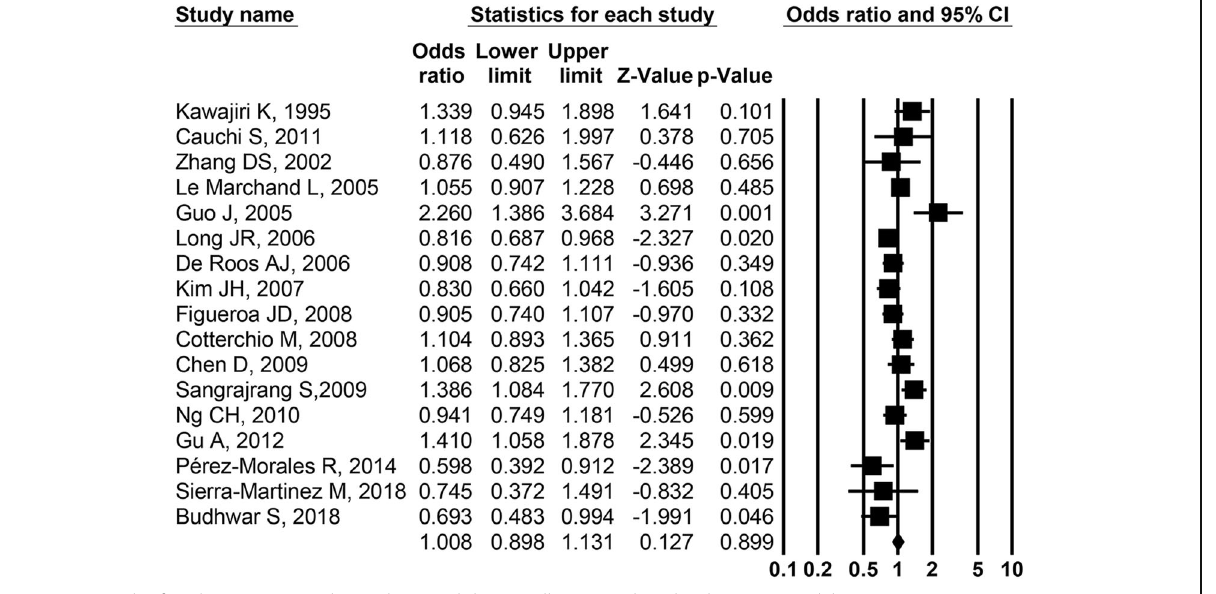
Fig. 2 Forest plot for AhR rs2066853 polymorphism and the overall cancer risk in the dominant